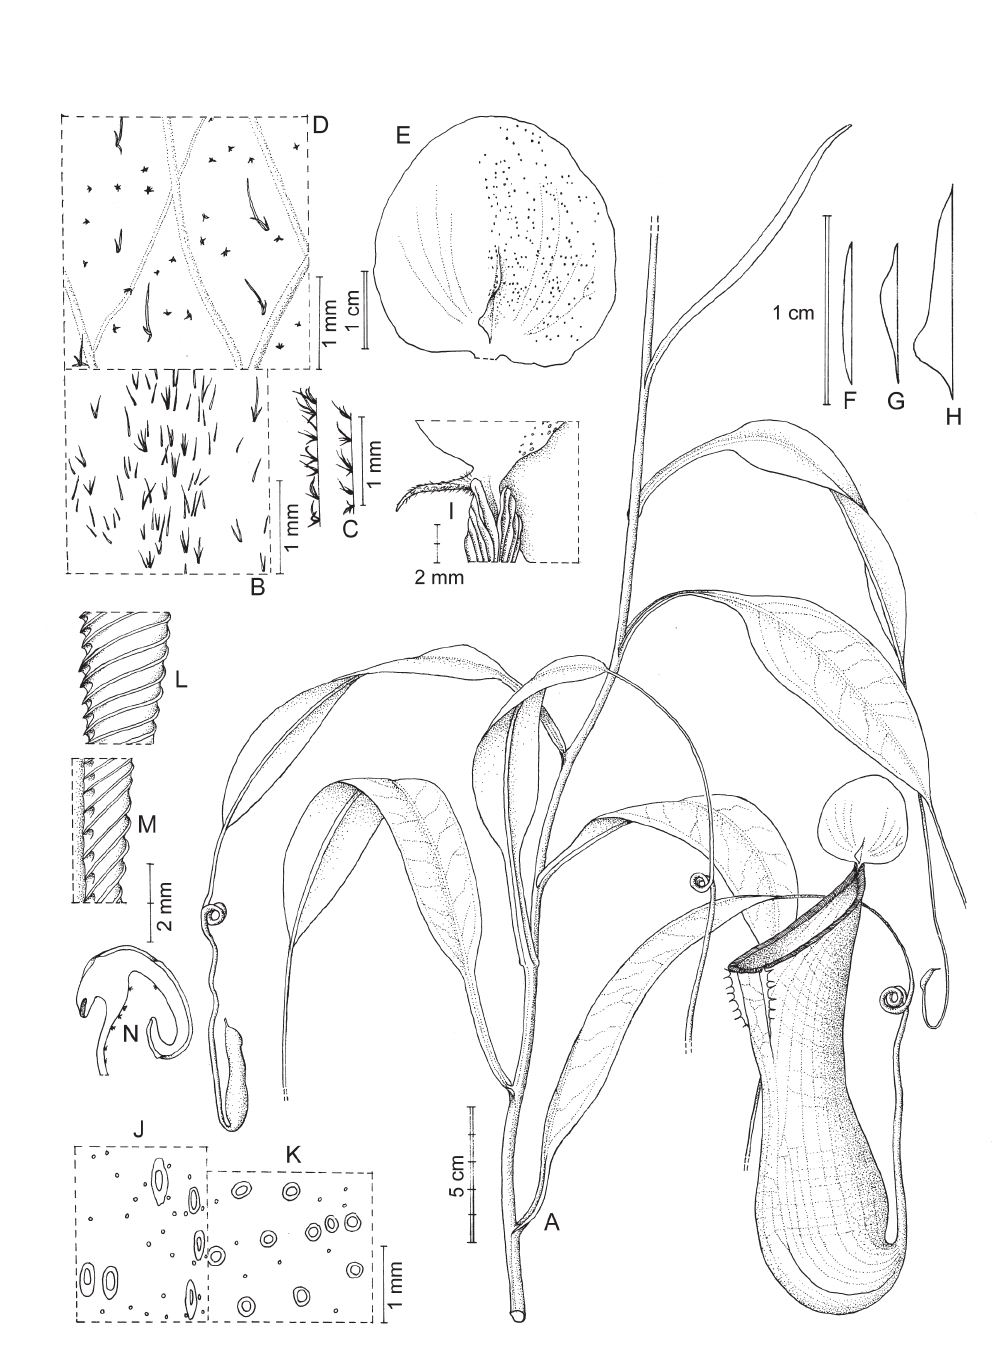
Fig. 1. Nepenthes kurata sp. nov. A . Habit, climbing stem with upper pitcher. B . Indumentum of midrib, lower surface of leaf-blade. C . Indumentum of tendril. D . Indumentum of outer pitcher surface. E . Lid, lower surface, showing nectar gland distribution on right (upper pitcher). F – G . Profiles of basal lid ridges, without appendage ( F ), with appendage weakly developed ( G ), and moderately developed ( H ). I Spur of intermediate pitcher. J . Longitudinally elliptic nectar glands of lid midline. K . Orbicular nectar glands of lid, outside the midline. L . Peristome from above, short teeth and holes discernible. M . Peristome viewed from inside pitcher. N . Peristome transverse section, outer surface to right. A–E, J & K from Gaerlan et al. PPI 10911 ; F–I, L–N from Mearns & Hutchinson 4632 . Scale bars: single = 1 mm; graduated single = 2 mm; double = 1 cm; graduated double = 5 cm. All drawn by Andrew